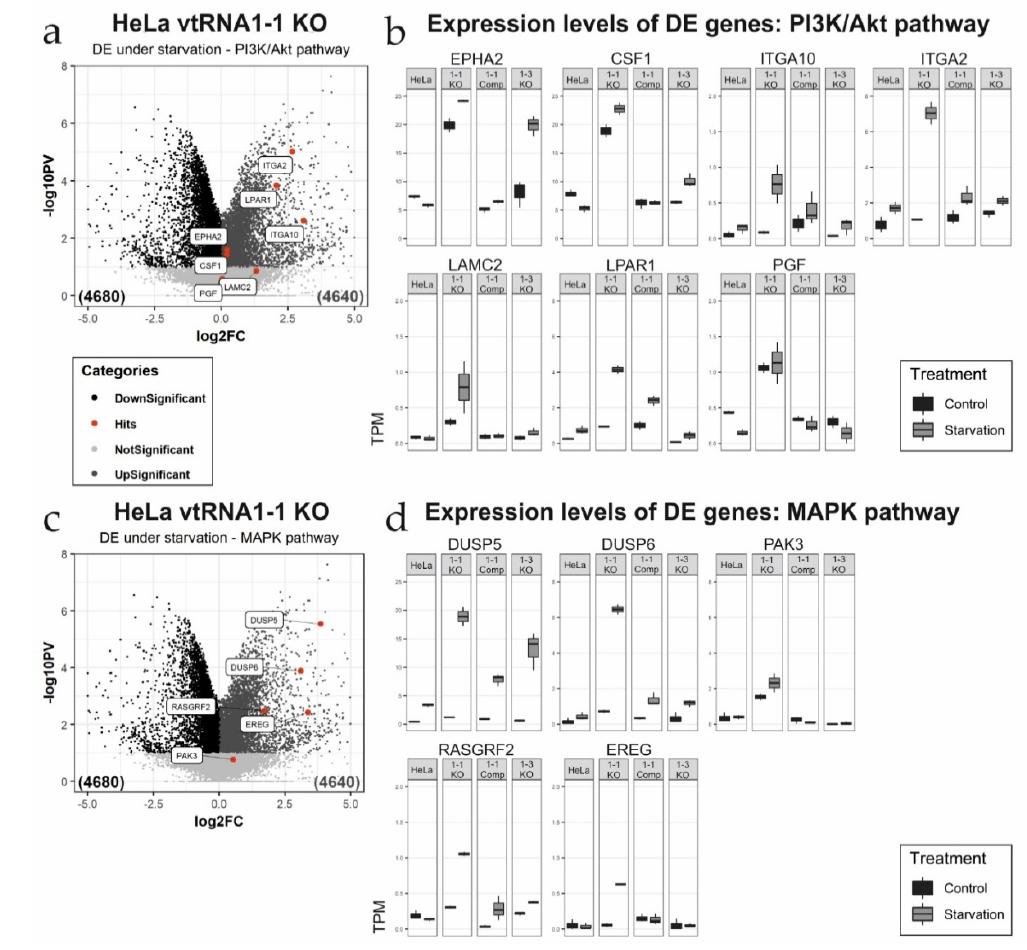
Figure 3. Differential expression analysis of genes involved in the PI3K/Akt pathway and the MAPK cascade. ( a , c ) Volcano plots illustrating differentially expressed (DE) genes comparing the vtRNA1-1 knock-out cells after 24 h starvation with chloroquine to the corresponding untreated control samples. Genes annotated either with the PI3K/Akt pathway ( a ) or the MAPK pathway ( c ), are highlighted (red dots) and flagged. ( b , d ) Box plots depicting the individual expression levels of the same genes highlighted in the volcano plots in all four cell lines used under control and starvation conditions. Gene transcript abundancies are indicated as transcripts per kilobase million (TPM) for the PI3K/Akt pathway ( b ) and the MAPK pathway ( d ), respectively.